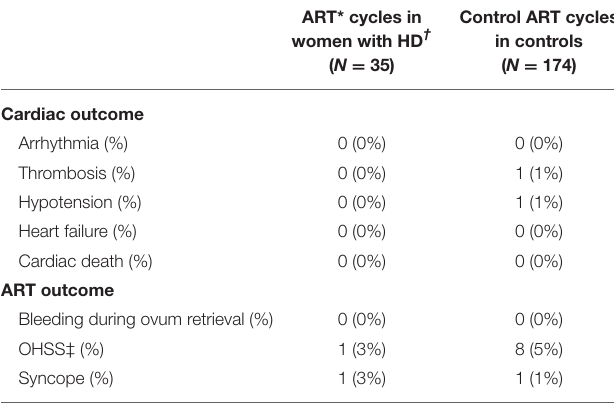
ART* cycles in Control ART cycles women with HD † in controls ( N = 35) ( N =